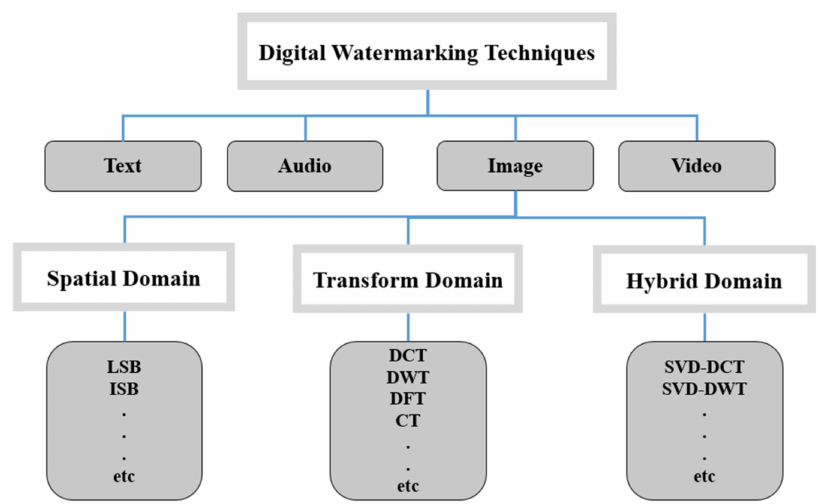
Figure 3. Watermarking techniques